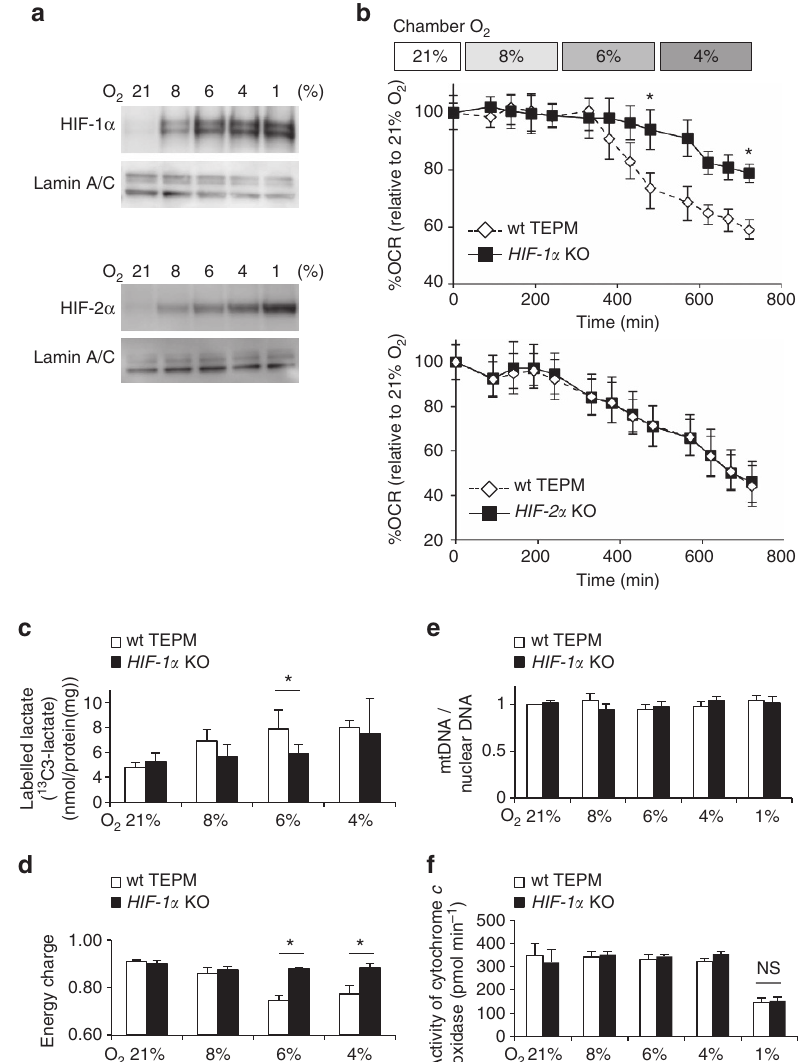
Figure 2 | HIF-1 a -dependent glycolytic reprogramming in mild hypoxia. ( a ) HIF-1 a and HIF-2 a protein abundance in wild-type TEPMs under each O 2 concentration (21, 8, 6, 4 or 1% O 2 , 4h) was determined by immunoblot analysis. Lamin A/C was used as a loading control. ( b ) OCR of TEPMs under mild hypoxia (8% O 2 , 4h-6% O 2 , 4h-4% O 2 , 4h) was plotted as percent to OCR in 21% O 2 ( y axis) versus time ( x axis). ( c ) The lactate production in hypoxic peritoneal macrophages was detected by using capillary electrophoresis (CE)-electrospray ionization (ESI)-mass spectrometry (MS). n ¼ 5 animals. ( d ) Energy charge was calculated with following formula: (ATP) þ 0.5 (ADP)/((ATP) þ (ADP) þ (AMP)). ( e ) Mitochondrial DNA (mtDNA) content measured relative to nuclear DNA in TEPMs under normoxia and hypoxia (21, 8, 6, 4 and 1% O 2 , 4h). The results were shown relative to mtDNA/nuclear DNA in 21% O 2 . n ¼ 3 animals. ( f ) The cytochrome c oxidase activity of TEPMs was calculated as OCR in the presence of ascorbate (100mM) and TMPD (1mM; 8% O 2 , 4h-6% O 2 , 4h-4% O 2 , 4h-1% O 2 , 4h). All graphs indicate average with s.d. All experiments using XF24 were repeated three times. Student’s t -test was performed to calculate P value. * P o 0.05 wt TEPM versus HIF-1 a KO; NS, not significant; wt TEPM, Tie2-Cre (cid:2) / (cid:2) HIF-1 a flox/flox mice or Tie2-Cre (cid:2) / (cid:2) HIF-2 a flox/flox mice; HIF-1 a KO, Tie2-Cre þ / (cid:2) HIF-1 a flox/flox mice; HIF-2 a KO, Tie2-Cre þ / (cid:2) HIF-2 a flox/flox mice; 21, 8, 6, 4, 1% O 2 concentration,